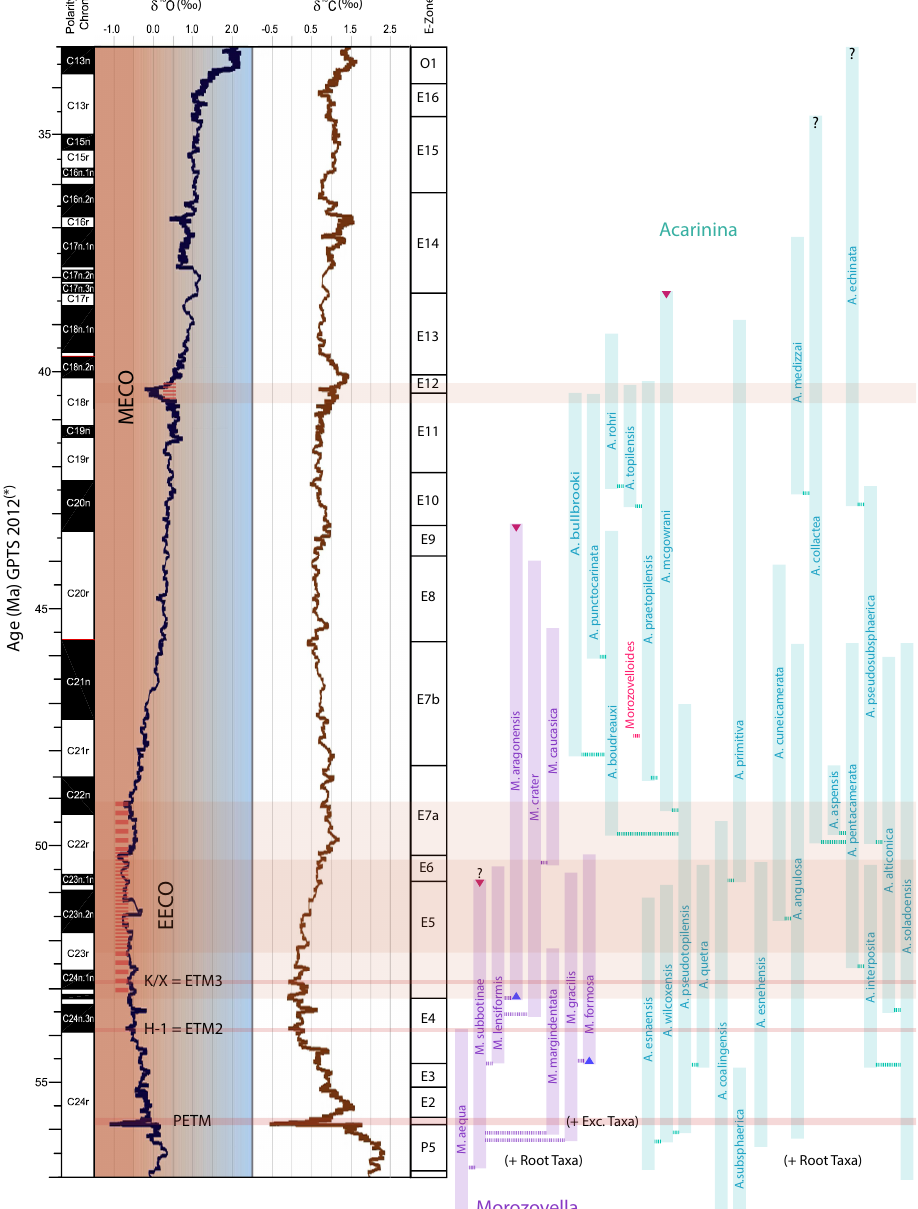
Figure 1. Evolution of climate, carbon cycling and planktic foraminifera across the middle Paleogene on the Geomagnetic Polarity Time Scale (GPTS) 2012 timescale. The left side shows polarity chrons and smoothed oxygen and carbon isotope records of benthic foraminifera, slightly modified from Vandenberghe et al. (2012). Oxygen and carbon isotope values come from compilations by Zachos et al. (2008) and Cramer et al. (2009). The middle of the figure indicates planktic foraminiferal biozones by Wade et al. (2011) with three modifications. The lower boundary for Zone E7a is now based on the first occurrence of Astrorotalia palmerae due to diachroneity in the first appearance of the previously selected marker Acarinina cuneicamerata (Luciani and Giusberti, 2014). The base of Zone E5, identified by the first appearance of Morozovella aragonensis , occurs in the middle of C24n instead of lower C23r (see text). A question marks the top of Morozovella subbotinae because there is diachroneity for this occurrence (see text). Right side shows a partial view of Morozovella and Acarinina evolution as envisioned by Pearson et al. (2006) and Aze et al. (2011). It does not include several “root taxa” that disappear in the earliest Eocene (e.g., M. velascoensis ) or “excursion taxa” that appear during the Paleocene–Eocene Thermal Maximum (PETM) (e.g., M. allisonensis ). Superimposed on these records are key intervals of climate change, including the Early Eocene Climatic Optimum (EECO), the Middle Eocene Climatic Optimum (MECO) and the three well-documented early Eocene hyperthermal events. The extent of the EECO is not precise because of stratigraphic issues (see text). Red and blue triangles: top and base of the Morozovella and Acarinina zonal markers.